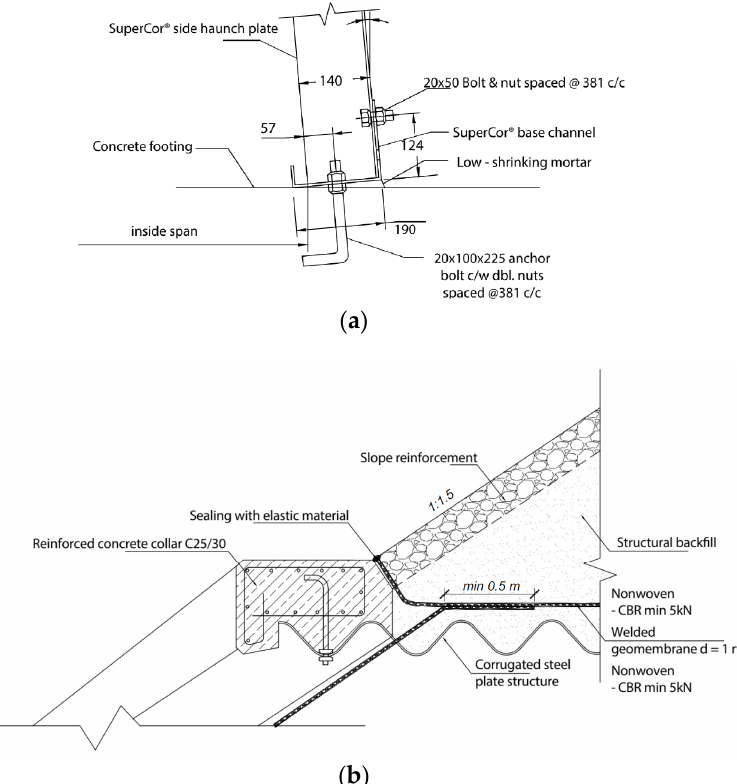
Figure 6. Example of: ( a ) footing connection with CSP shell and ( b ) RC collar connection with CSP